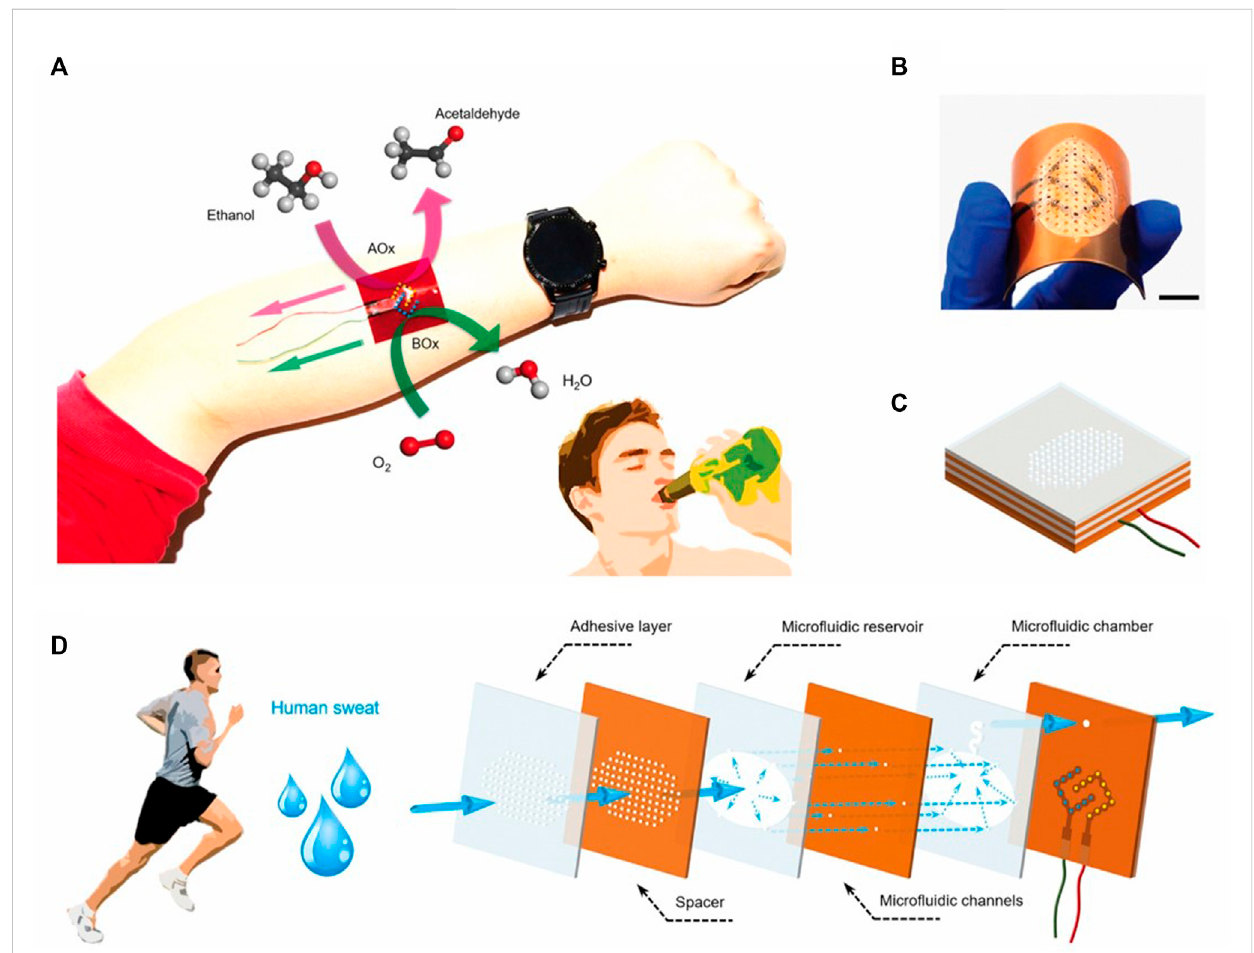
FIGURE 4 (A) Schematic illustration of a fl exible and wearable epidermal ethanol BFC that harvests bioenergy in real-time from the perspiration of individuals after drinking alcohol. (B) Optical photo of a fl exible epidermal ethanol BFC (scale bar, 1 cm). (C) Schematic illustration of an epidermal ethanol BFC. (D) Schematic illustration of the micro fl uidic module for continuous real-time in situ fresh sweat sampling, transfer, storage, and excretion on human skin (Sun et al.,